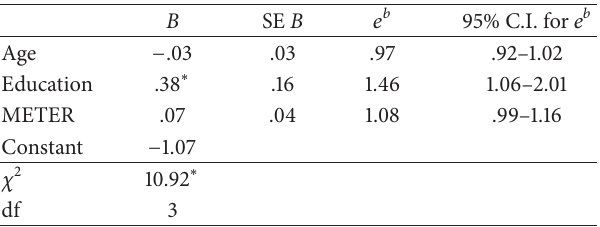
Table 4: Logistic regression analysis predicting internet use from age, education, and health literacy (METER).